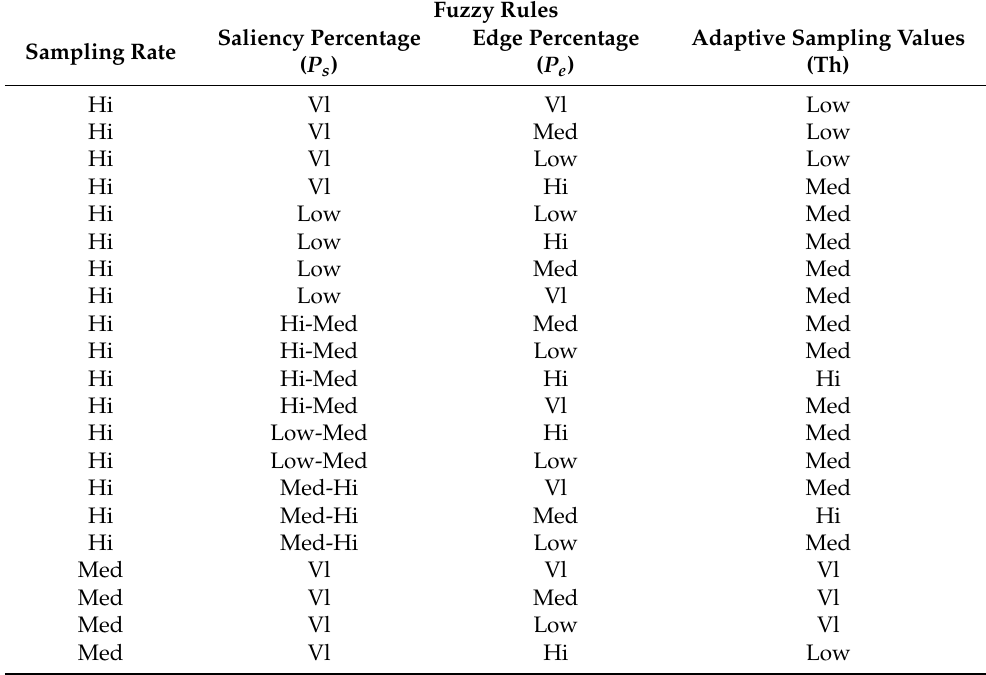
Figure 3. Graphical representation of Input and Output membership function. Table 1. Illustration of the Fuzzy Rules. Fuzzy